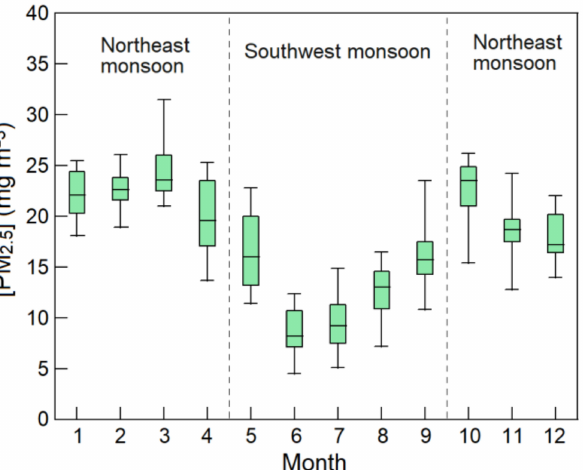
Figure 3. Box-whisker plots of monthly PM 2.5 average concentrations from 17 AQMSs in Taichung City in